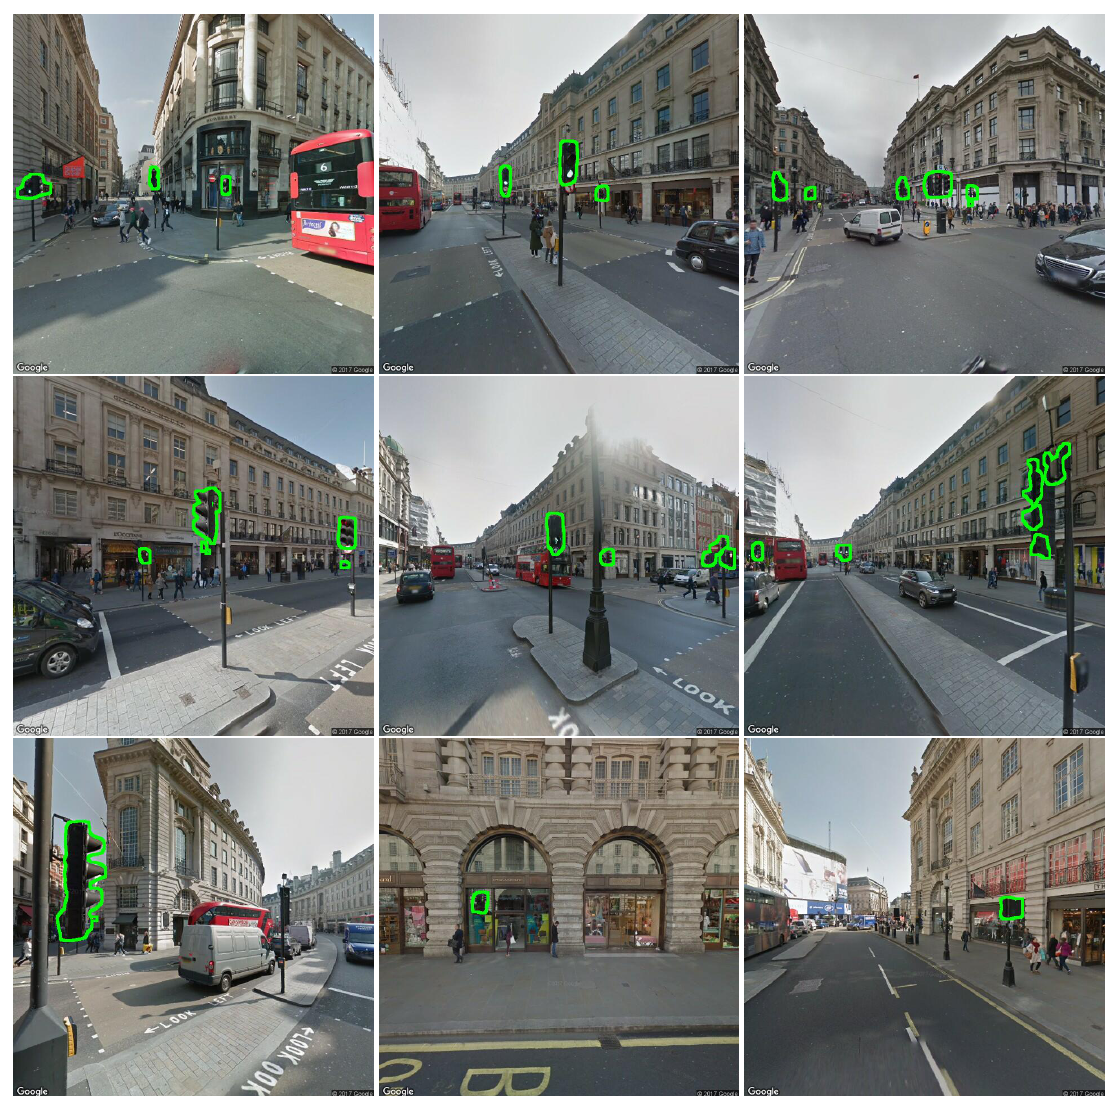
Figure 4. Traffic light segmentation on Google Street View images. First row: correct segmentation. Second row: noisy or incomplete segmentation. Third row: false negative (left) and false